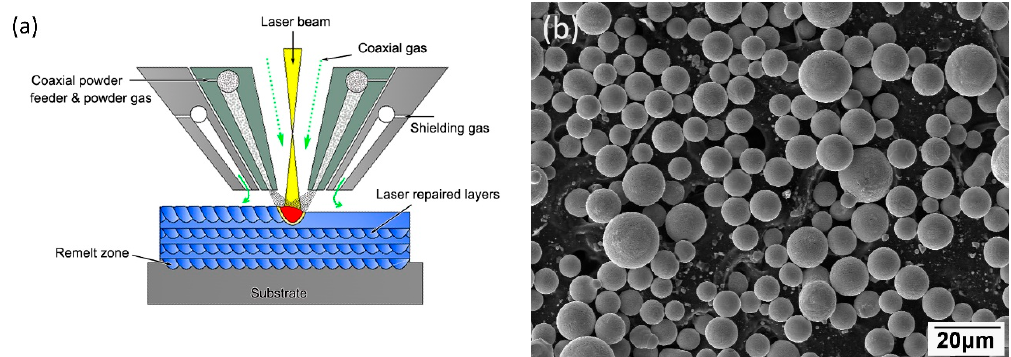
Figure 1. ( a ) Illustration of laser forming repair process and ( b ) scanning electron microscopy (SEM) micrographs of the as-received 34CrNiMo6 steel powder. Table 1. Chemical compositions of 34CrNiMo6 powder (wt %).